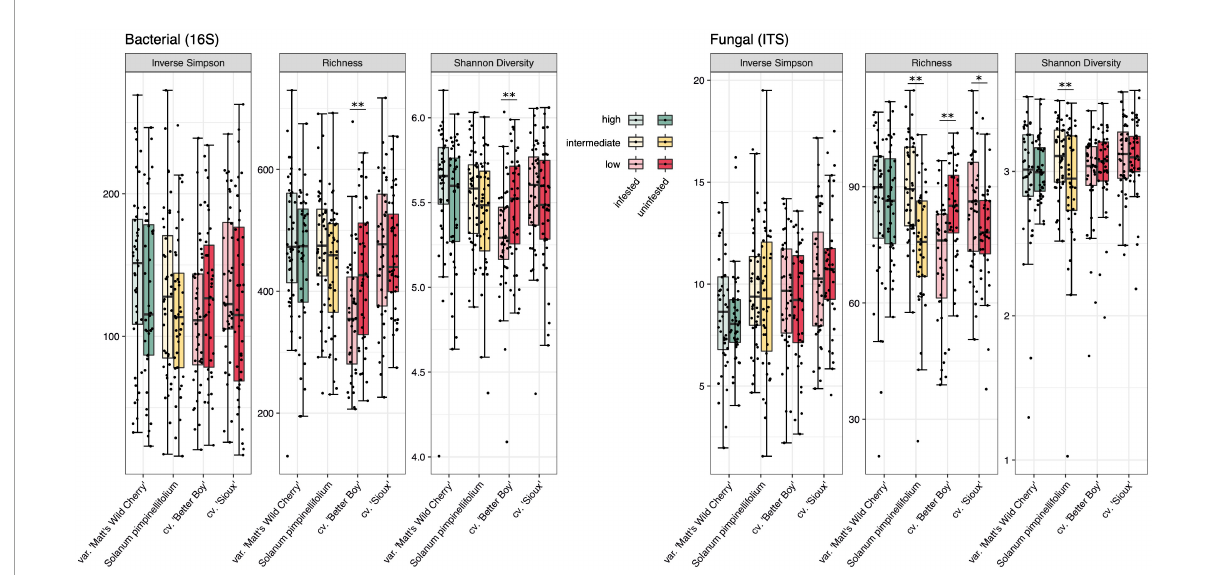
FIGURE3 Bacterial (left) and fungal (right) alpha diversity (as represented by inverse Simpson, richness and Shannon diversity) of four tomato lines separated by tobacco hornworm herbivory treatments. n = 38–40 for all treatments. Significant differences in alpha diversity between herbivory treatments are indicated (see Supplementary Table 7 ): ∗ denotes p < 0.05 and ∗∗ denotes p <